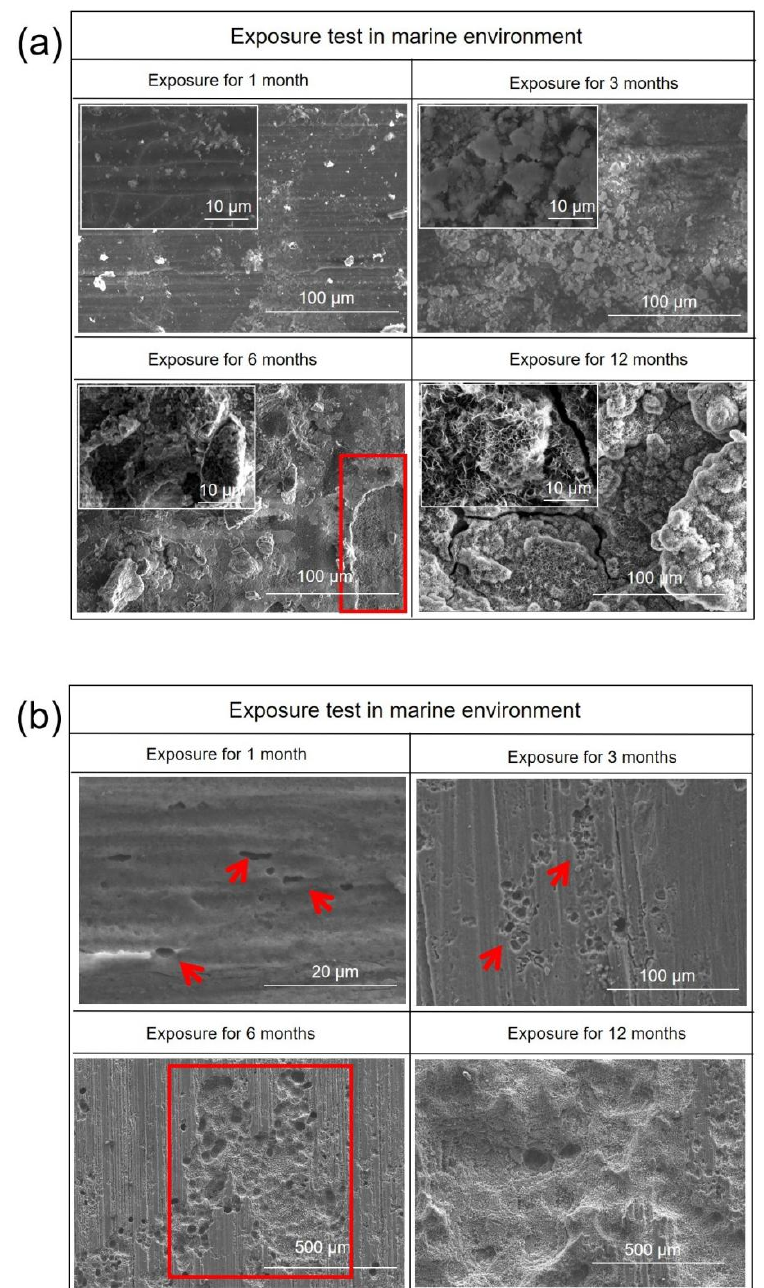
Figure 7. SEM images of the surface of AZ31 magnesium alloy specimens with corrosion products exposed for different periods in marine environment of ocean voyage: ( a ) with corrosion products, ( b ) without corrosion products.